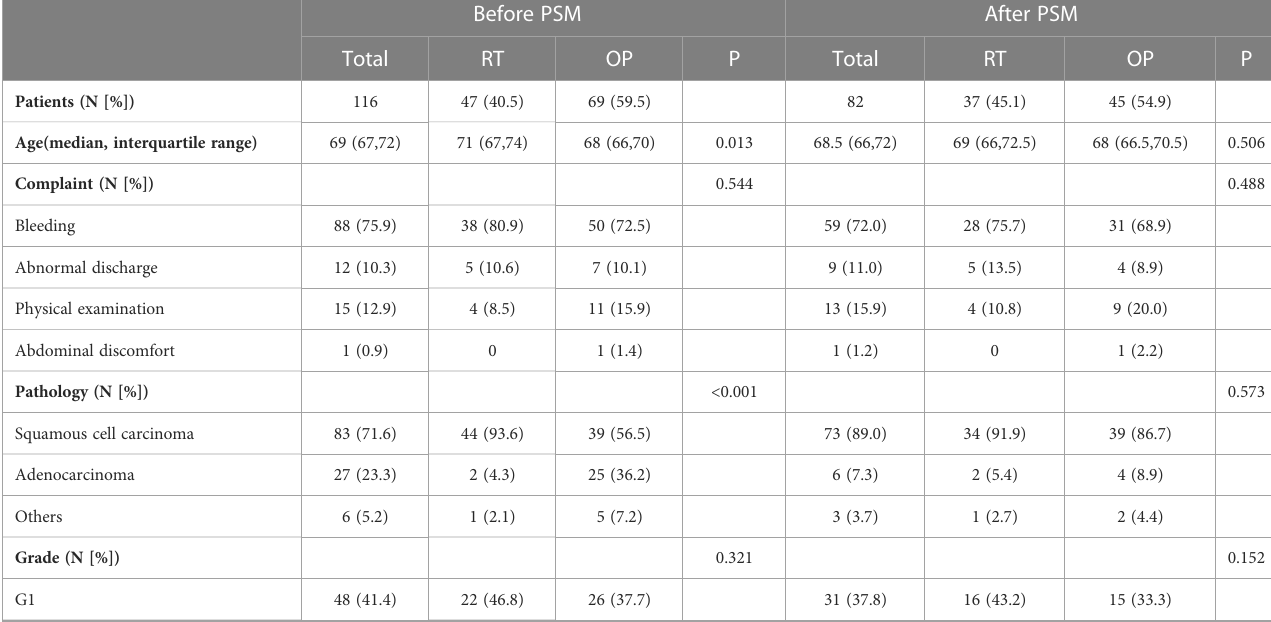
TABLE 1 Clinical characteristics of patients between two groups before and after